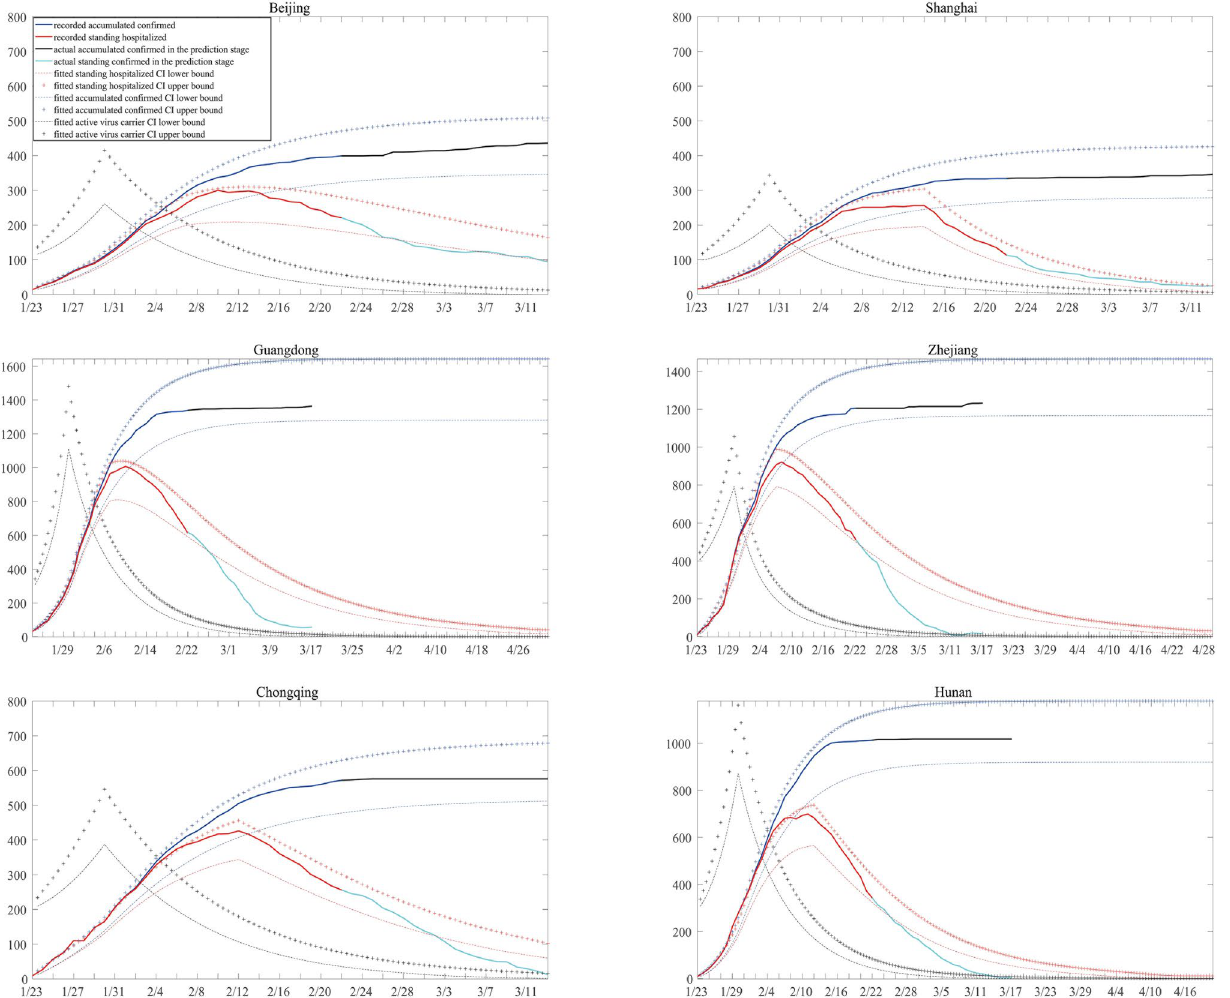
Figure 2. Predicted confidence interval for key